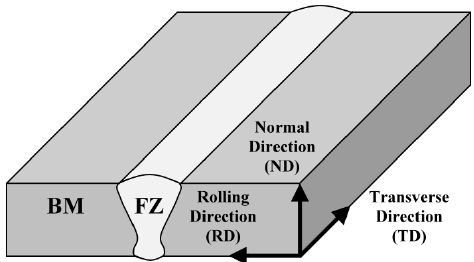
Figure 1. Schematic illustration showing the normal direction (ND), rolling direction (RD) and transverse direction (TD) of the weldment.